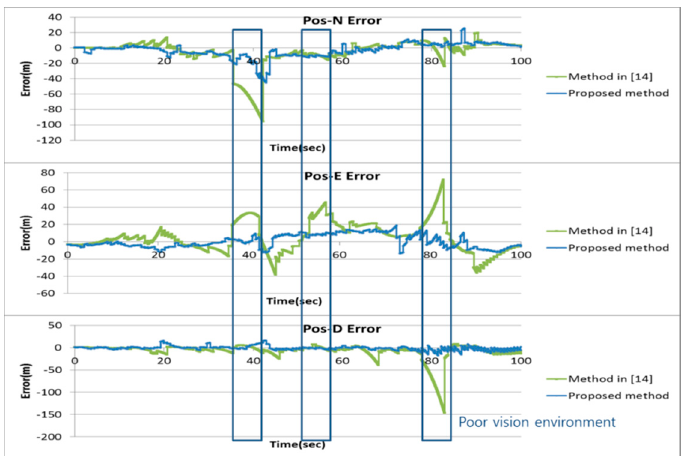
Figure 10. Navigation results of the experiment.